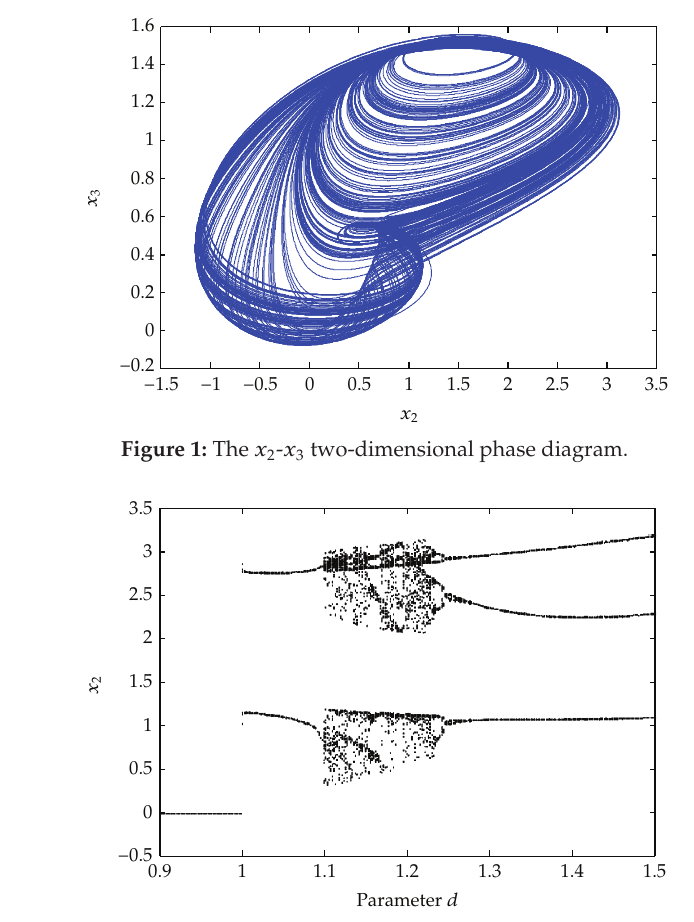
Figure 2: The bifurcation diagrams varying with d